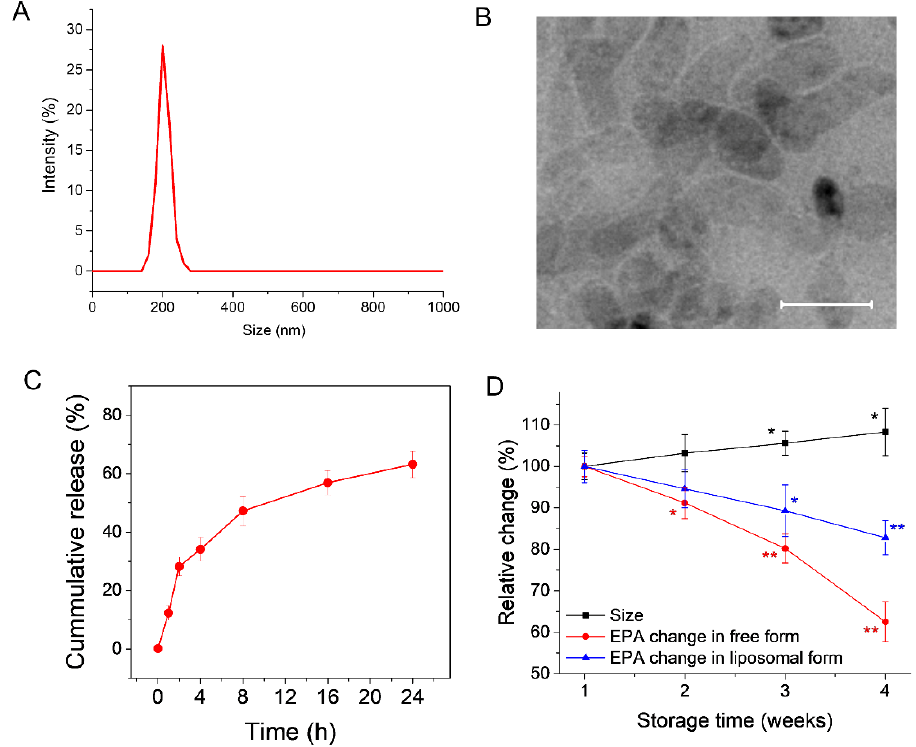
Figure 2. Characterization of EPA-liposomes. ( A ) Size distribution of the EPA-liposomes measured by DLS. ( B ) TEM imaging of the EPA-liposomes. Scale bar 200 nm. ( C ) The release profile of EPA from of the EPA-liposomes in PBS at 37 °C with shaking. ( D ) The change of size of the EPA-liposomes, the change of free EPA in PBS and the liposomal EPA in PBS over time when sored at 4 °C. * p < 0.05, ** p < 0.01 compared to the individual first measurement. n = 6 for size measurement. The data are expressed as means ± SD, n = 3 unless otherwise specified.